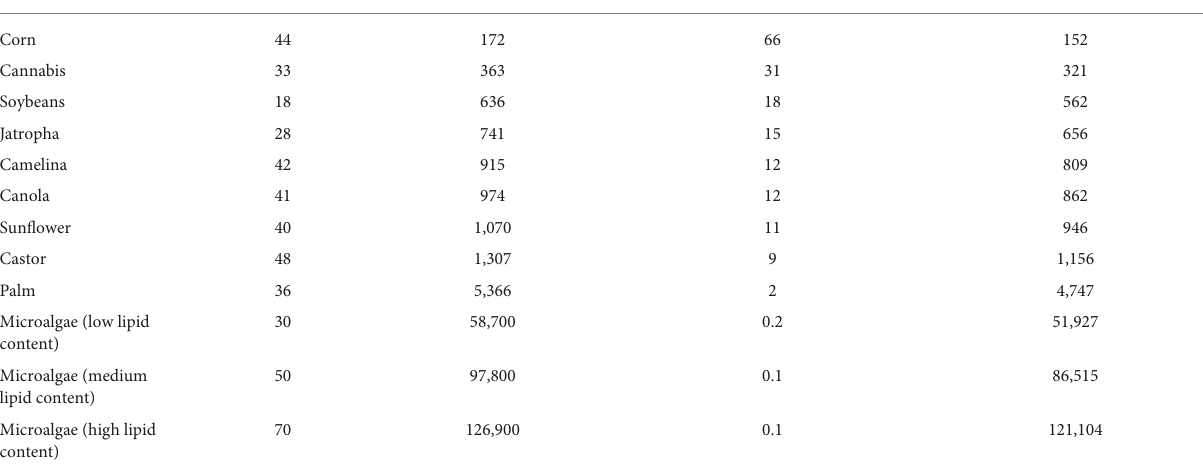
TABLE 1 Comparison of microalgae with other